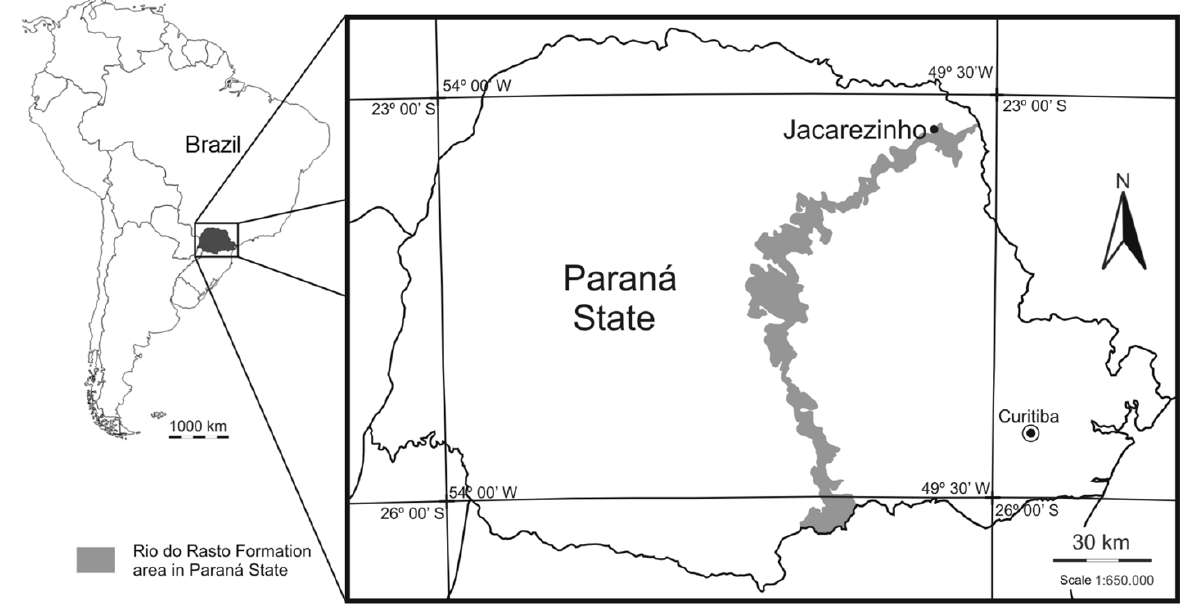
Figure 1 - Distribution of the Rio do Rasto Formation in the State of Paraná with the location of the collecting site in the municipality of Jacarezinho (modified from Mineropar,